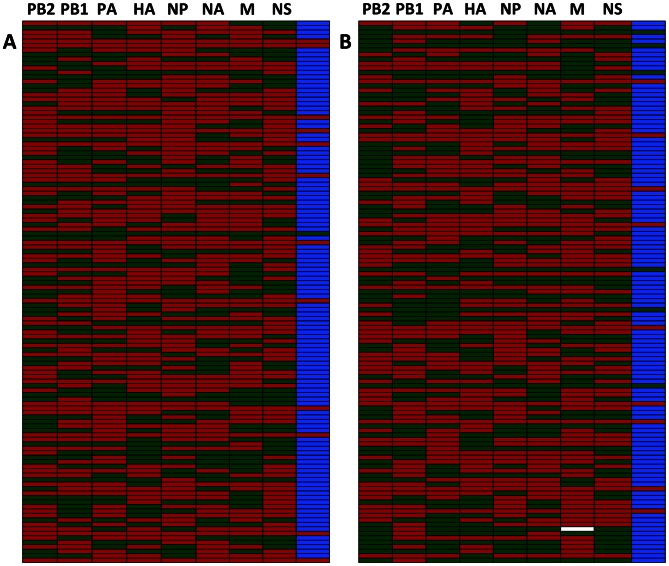
Reassortment in cultured cells is efficient under unbiased conditions.The results are shown of HRM genotyping analysis of 121 plaque isolates obtained from each of two culture dishes of MDCK cells co-infected at high MOI (10 PFU/cell). In A, 108/121 (89.3%) had reassortant genotypes and in B, 106/121 (87.6%) had reassortant genotypes. This experiment was done in the presence of trypsin. Green coloring indicates a segment derived from rPan/99var virus; red coloring indicates a segment derived from Pan/99wt virus; white indicates a segment that was untyped. The right-most column in each chart shows the overall genotype: green for var, red for wt and blue for reassortant.